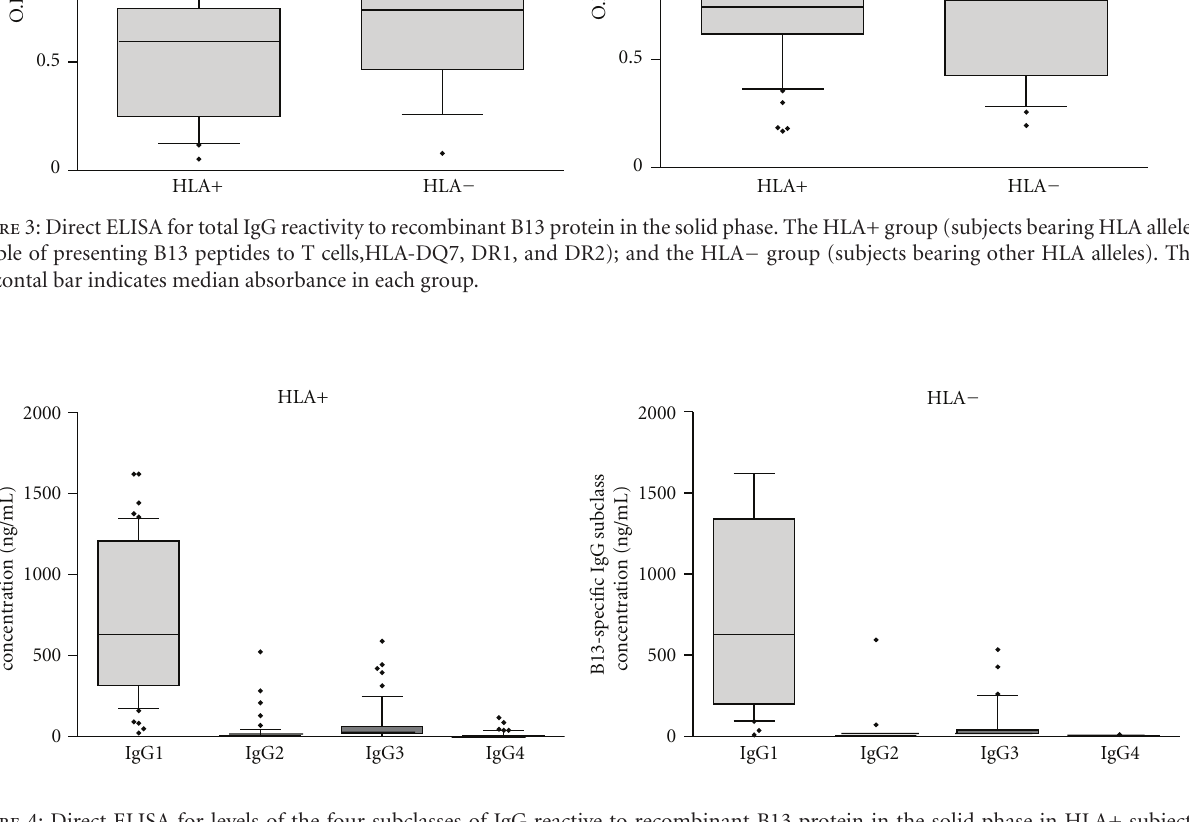
Figure 4: Direct ELISA for levels of the four subclasses of IgG reactive to recombinant B13 protein in the solid phase in HLA+ subjects ( n = 53) and HLA − subjects ( n = 34). The horizontal bar indicates median concentration of each IgG subclass in each group: IgG1; IgG2; IgG3; IgG4.